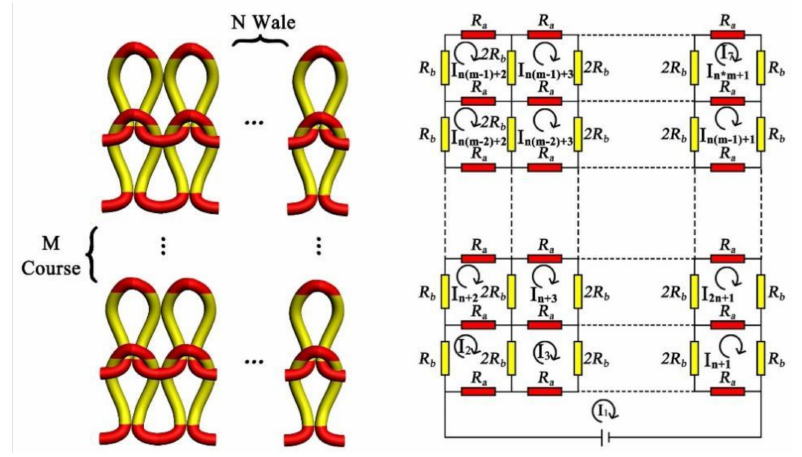
Figure 7. The equivalent circuit of the knitted strain sensor with M course × N wale.